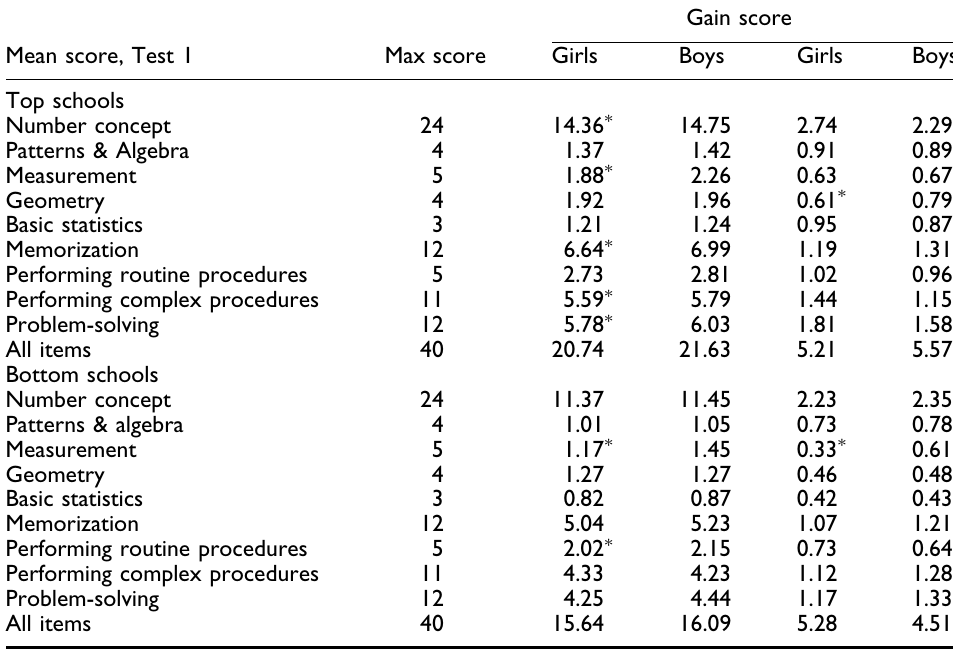
Table 1. Gender differences in maths achievement by curriculum outcome areas and levels of cognitive demand of test